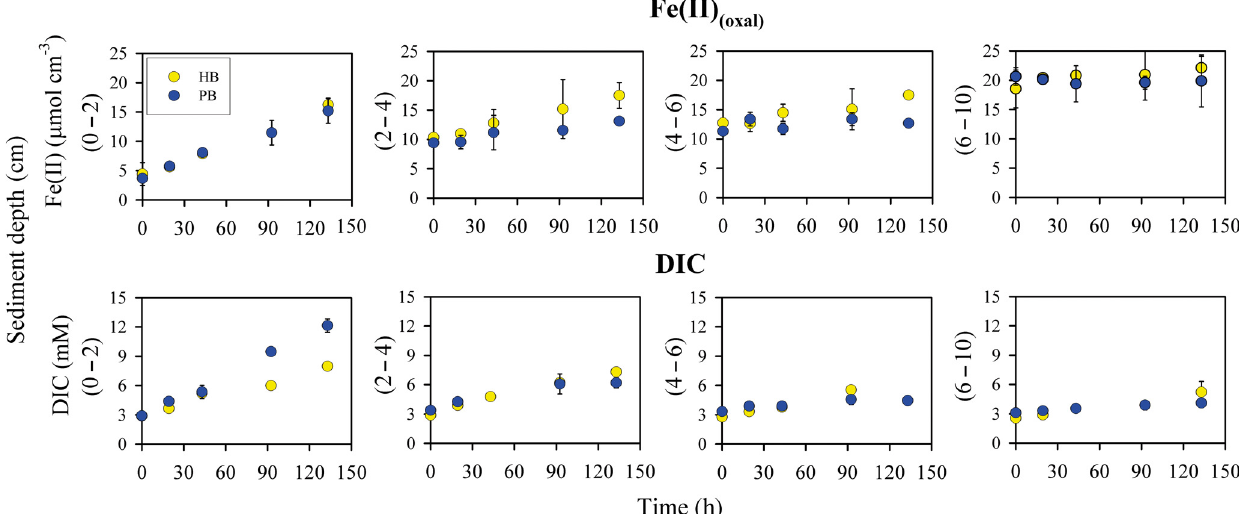
Fig. A1. Changes in Fe(II) (oxal) content in the sediment and changes in DIC concentrations in pore water during anoxic incuba- tion of sediment at depths of 0−2, 2−4, 4−6, and 6−10 cm at highly bioturbated (HB) and poorly bioturbated (PB) sites. Vertical bars indicate SE